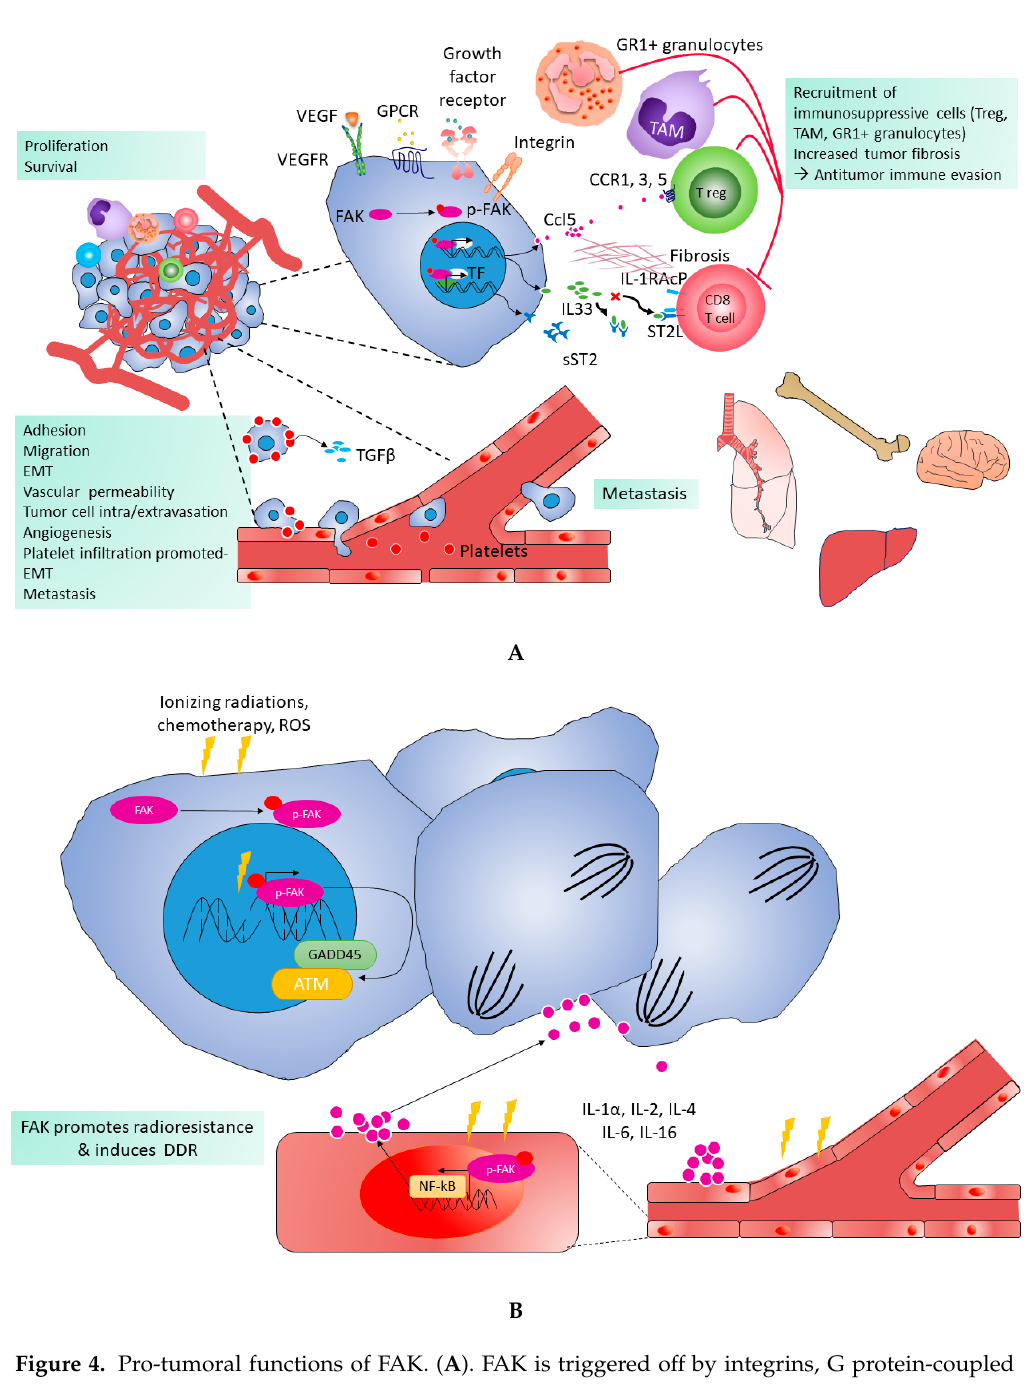
Figure 4. Pro-tumoral functions of FAK. ( A ). FAK is triggered off by integrins, G protein-coupled receptors (GPCR), growth factor receptors, and vascular endothelial growth factor receptor (VEGFR). Activated FAK promotes cell proliferation and survival. FAK also contributes to tumor progression and metastasis via cell adhesion, migration, and promotion of epithelial to mesenchymal transition (EMT). Transient contact between platelets and tumor cells induces TGF β production by the platelets, which promotes EMT-like transformation and invasive behaviour. In endothelial cell (EC), FAK drives angiogenesis, increases vascular permeability, and regulates platelet extravasation; this facilitates intravasation or extravasation of tumor cells, leading to metastasis. Additionally, FAK induces a tumor protective fibrotic and immunosuppressive tumor microenvironment that promotes antitumor immune evasion. Indeed, FAK induces cytokines (short soluble (sST2), IL33, Ccl5), which lead to the recruitment of immunosuppressive cells, such as regulatory T cells (Treg), tumor-associated macrophages